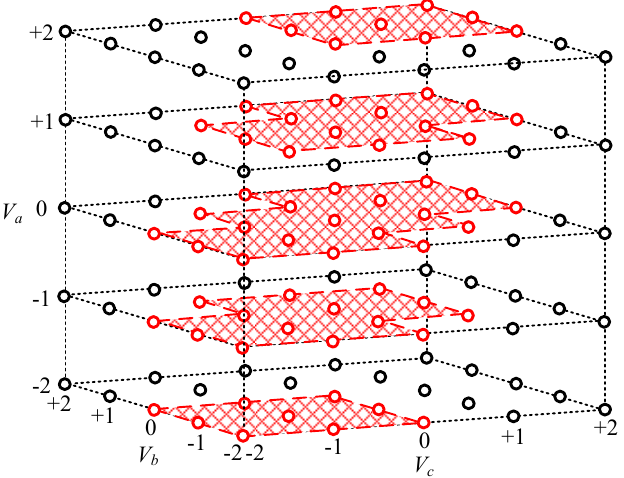
Figure 5. Possible voltage vectors per phase after restrictions [9].